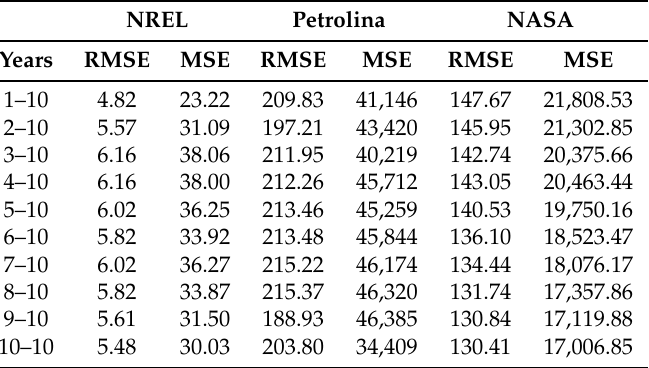
Table 1. Forecasting error for different training samples and durations accounting for different data sources.